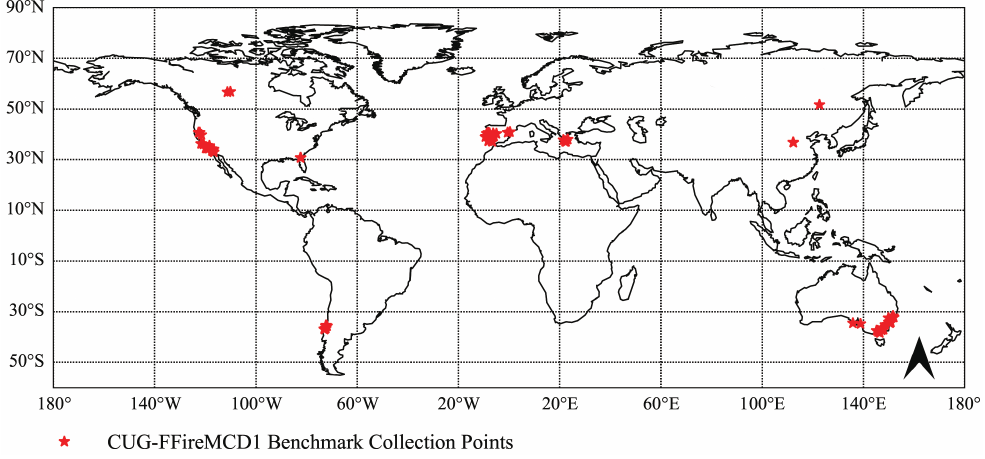
Figure 1. Collection geolocations for the CUG-FFireMCD1